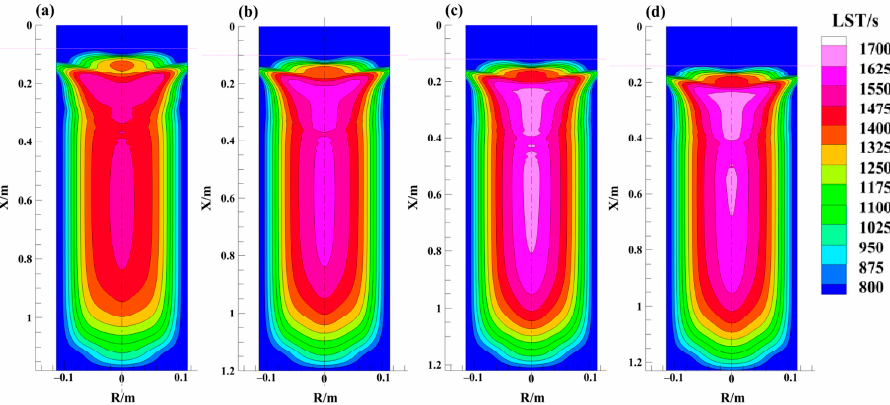
Figure A5. Distribution of SDAS with varying filling ratio: ( a ) 0.16, ( b ) 0.23, ( c ) 0.33 and ( d ) 0.43.